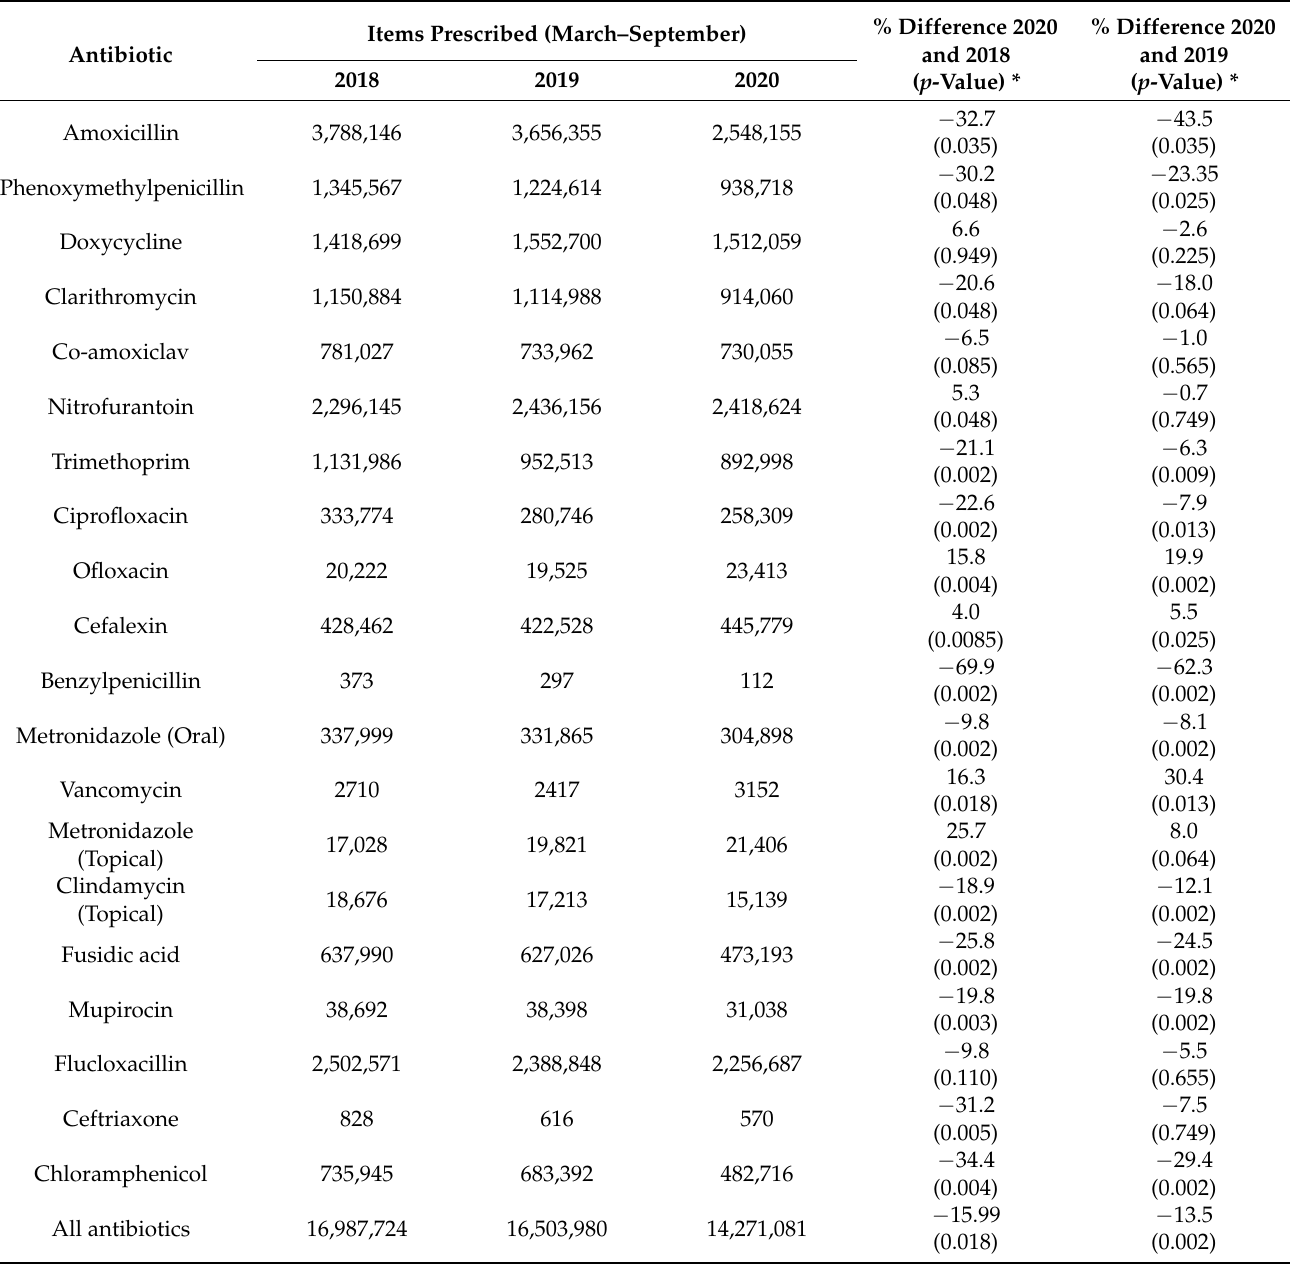
Table 1. Number of first-line antibiotics prescribed in English primary